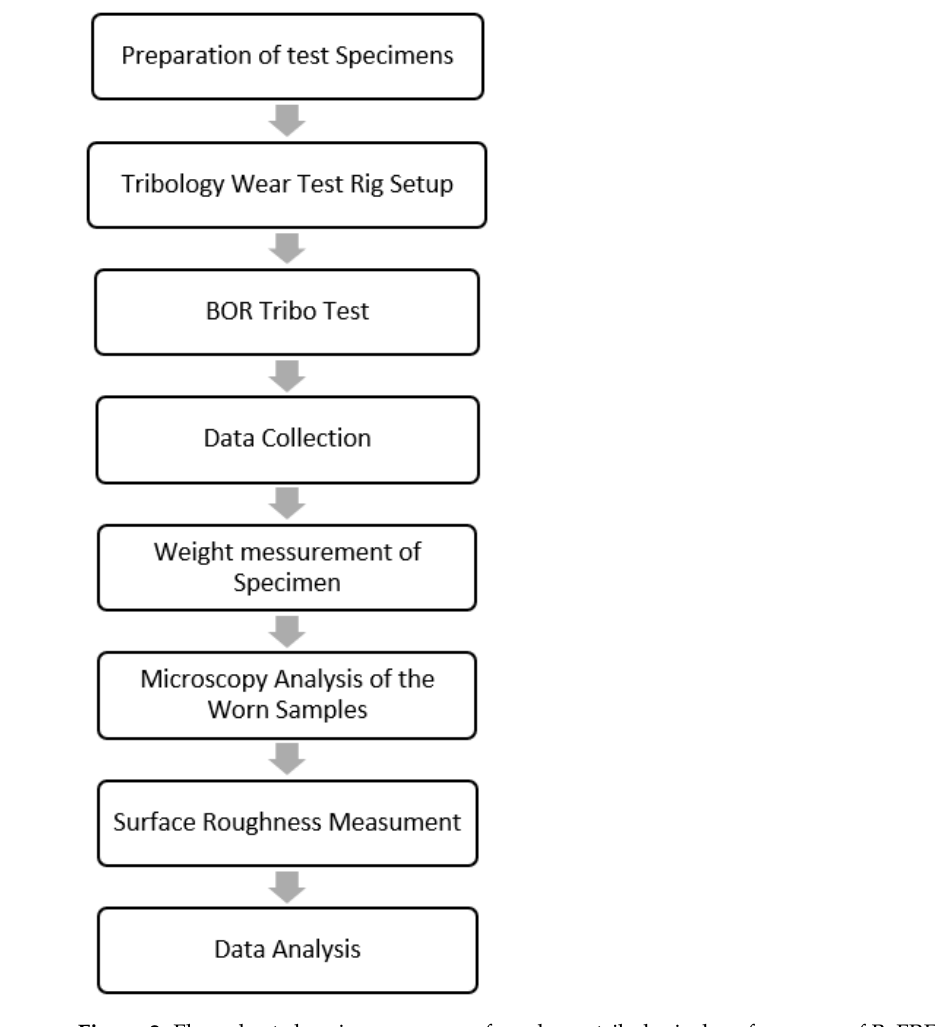
Figure 2. Flow chart showing sequence of works on tribological performance of BaFRE composite .